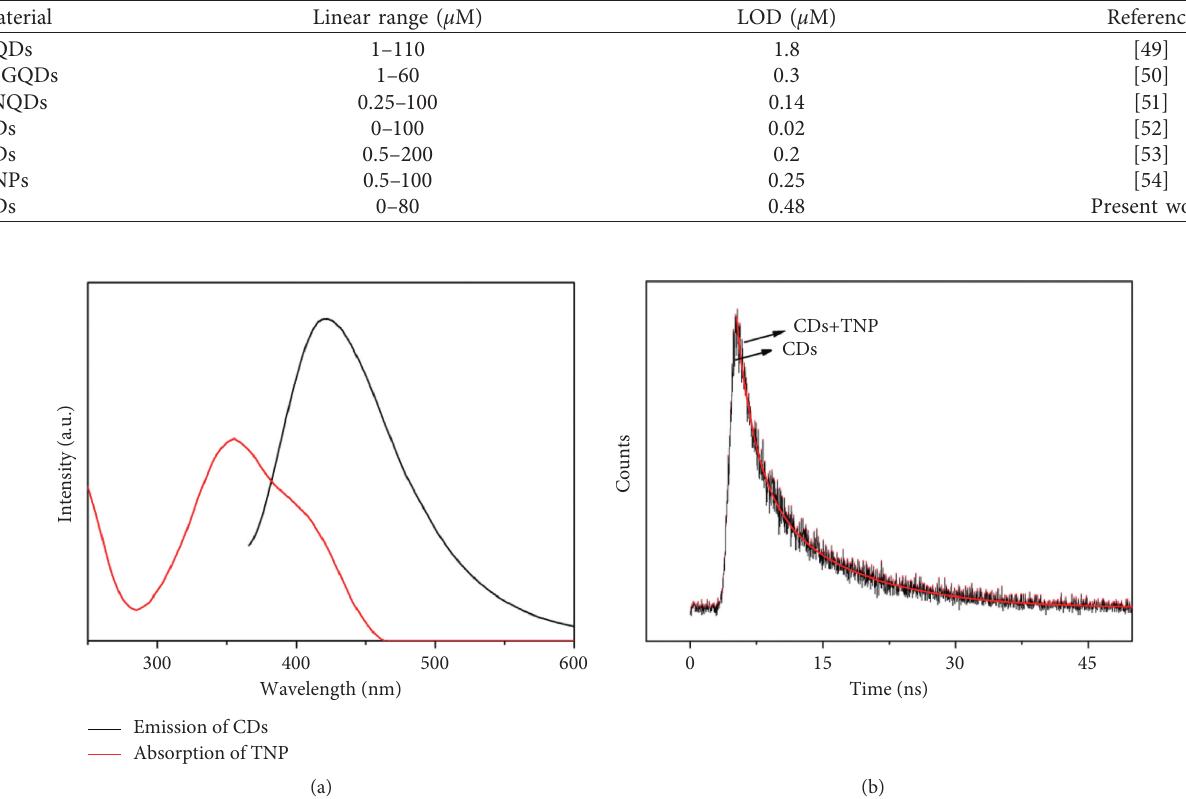
Figure 6: (a) The UV absorption spectrum of TNP and fluorescence spectrum of CDs. (b) The fluorescence lifetime and fitting curve of